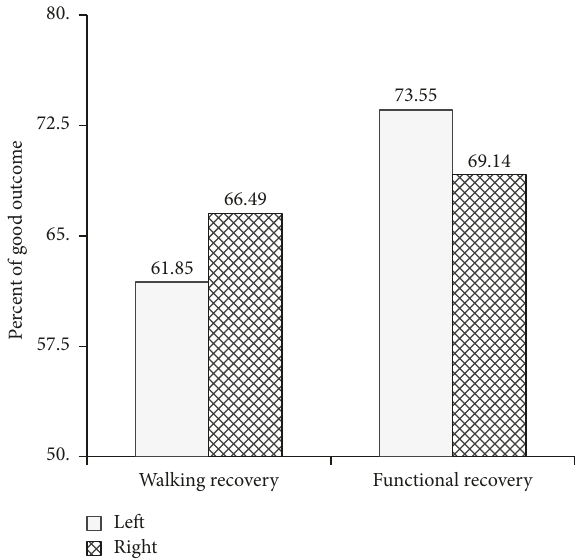
Figure 1: Proportion of patients with a left- or right-sided hemi- spheric lesion who achieved walking and functional